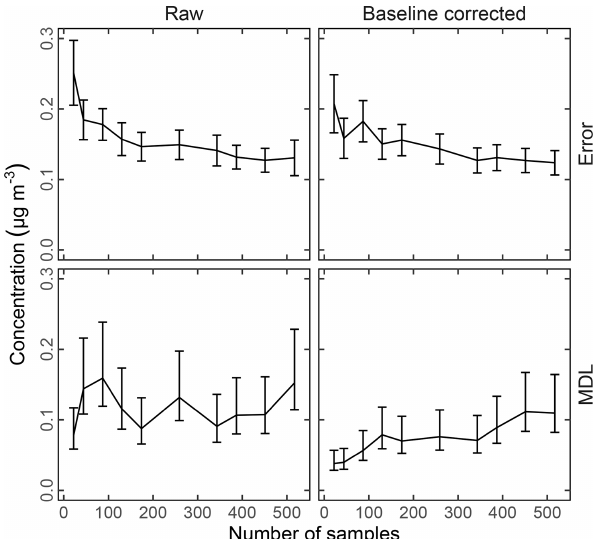
Figure 9. The prediction accuracy for TOR OC as a function of the number of ambient samples in the calibration set (the num- ber of blanks was kept constant at 36). Using the 2011 IMPROVE base case calibration model, every n th sample was removed (which leaves spatial and temporal representation of samples close to the original set). The performance metrics are computed on the same 286 test set samples for all calibration models.